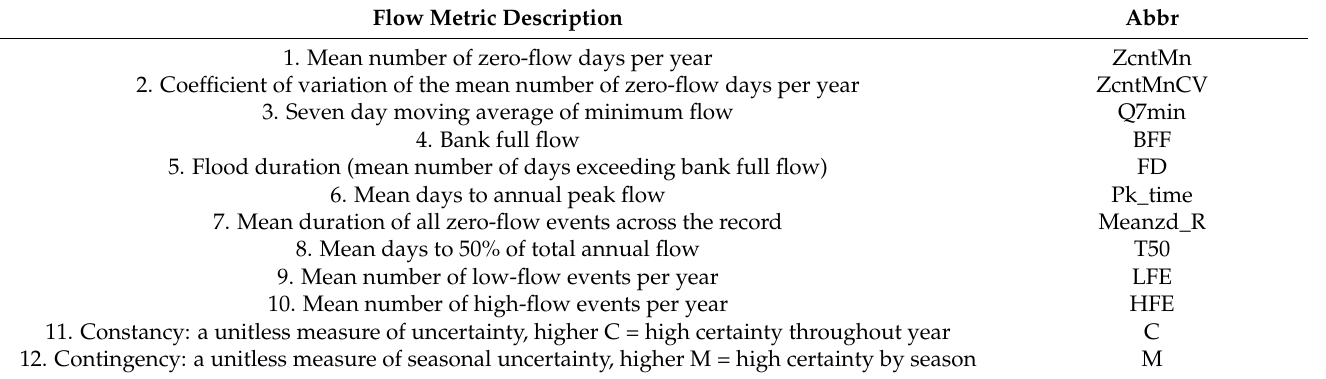
Table 2. The 12 flow metrics used in the hierarchical cluster analysis. Abbr = abbreviation. Flow Metric